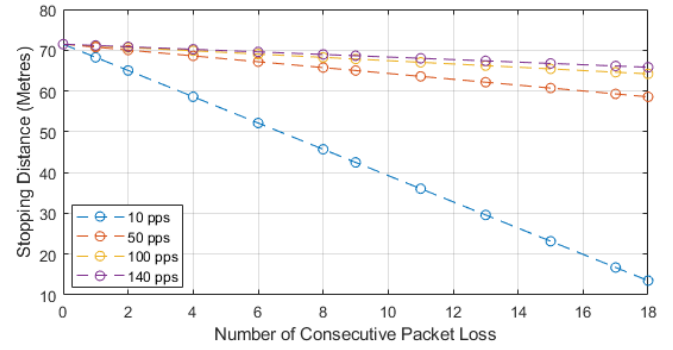
Figure 20. Joint loss—0% density losses.